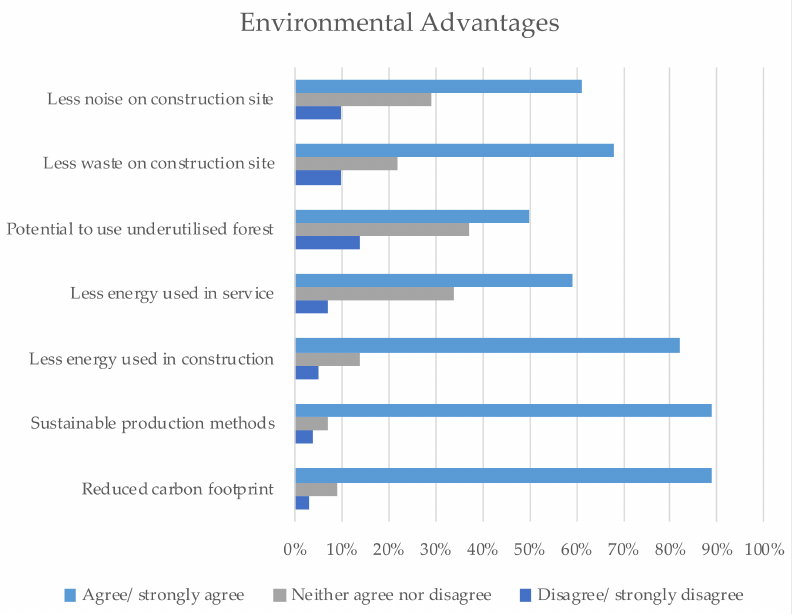
Figure 9. Responses to the statement, ‘The following is a list of possible environmental advantages associated with timber multi-storey buildings. Indicate your level of agreement or disagreement with each of the following possibilities as they relate to the environmental advantages of timber multi-storey